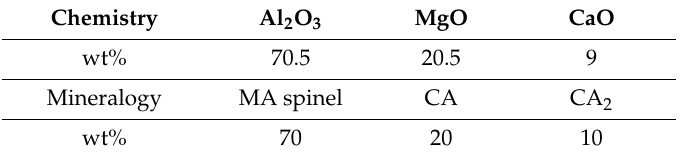
Table 1. Composition of MagArmour (MagA) aggregate.